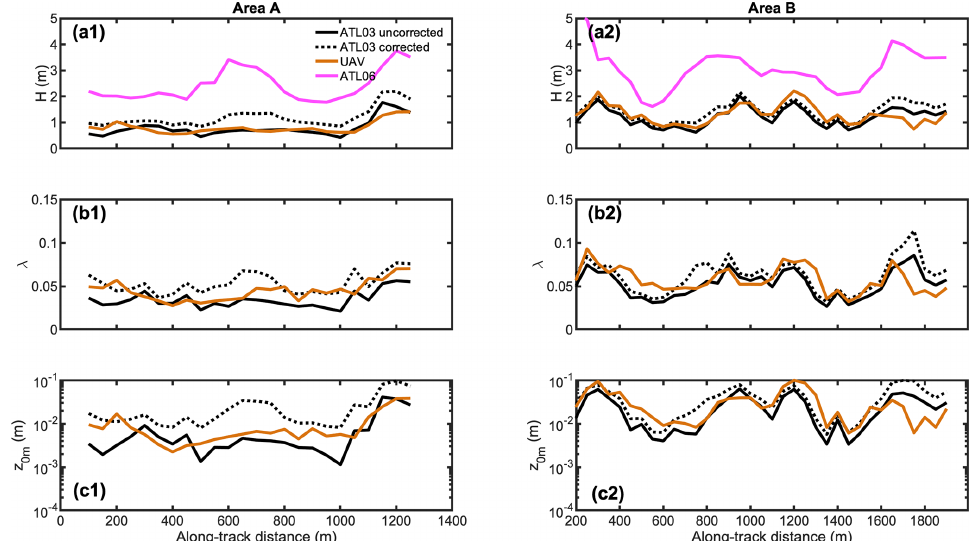
Figure 7. (a1, a2) Estimated height of the roughness obstacles ( H ). (b1, b2) Estimated frontal area index. (c1, c2) Estimated aerodynamic roughness length ( z 0m ). (a1, b1, c1) Area A. (a2, b2 c2) Area B. The black lines denote the roughness statistics estimated from the ATL03 filtered profile, with or without accounting for the residual photon elevations (dashed and solid lines, respectively). The orange line denotes estimates using UAV elevation profiles, and the pink line denotes the height of obstacles estimated using the scatter of ATL03 photons detrended for the ATL06